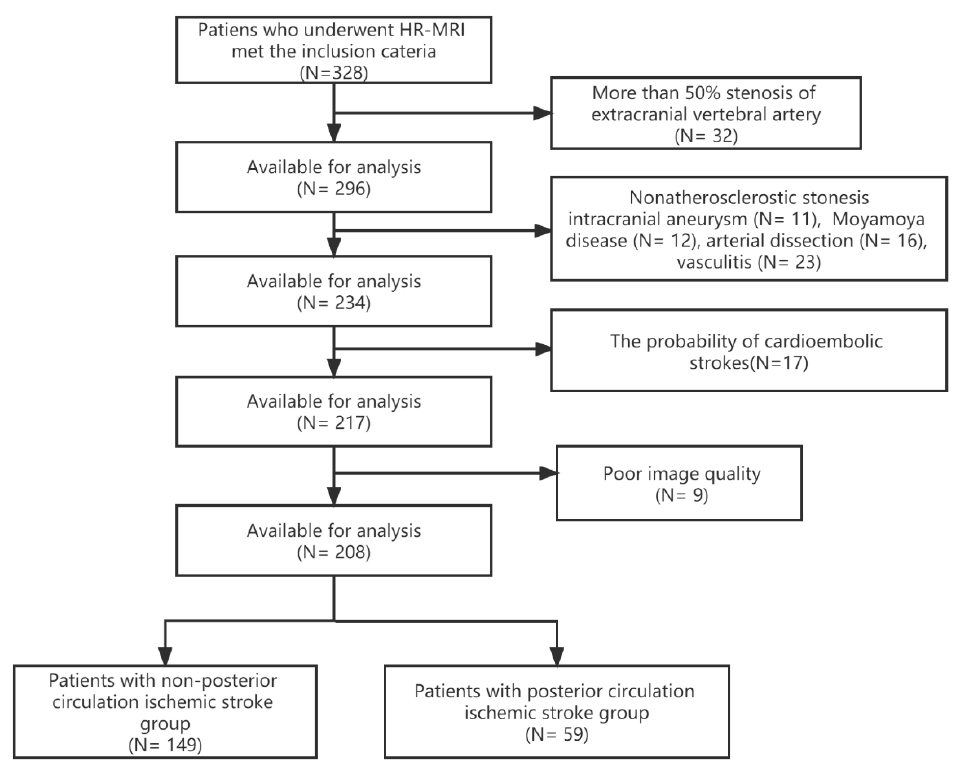
Figure 1. Theflowchartfortheinclusionofpatients. Figure 1. The flow chart for the inclusion of patients. HR-MRI, high-resolution magnetic resonance imaging.